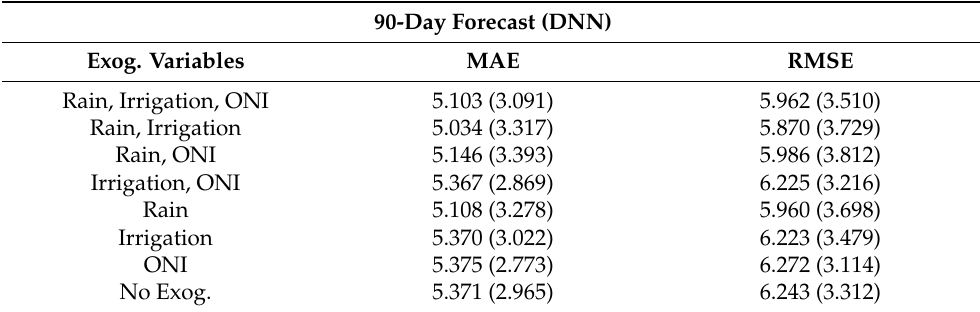
Table 10. Average estimates for MAE and RMSE, and their standard deviations calculated using TSCV for a 90-day forecast across different combinations of exogenous variables.